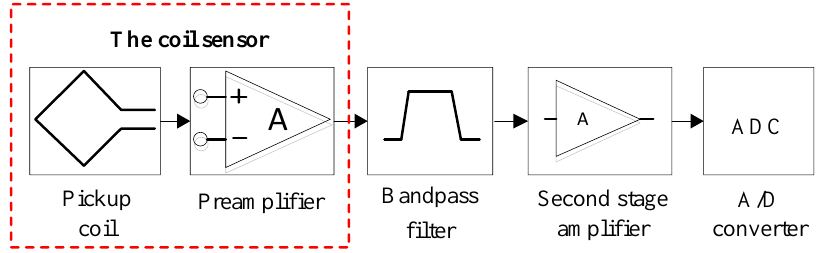
Figure 3. The traditional MRS data acquisition system.